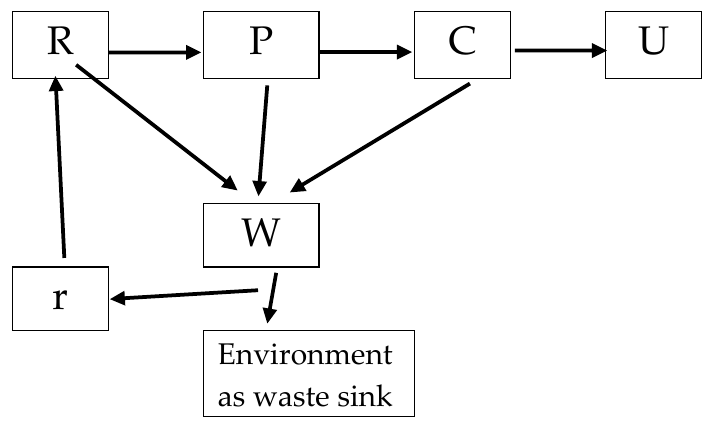
Figure 2. Circular economy processes. r—Recycling, W—waste. Source: Andersen, M.S. [29].